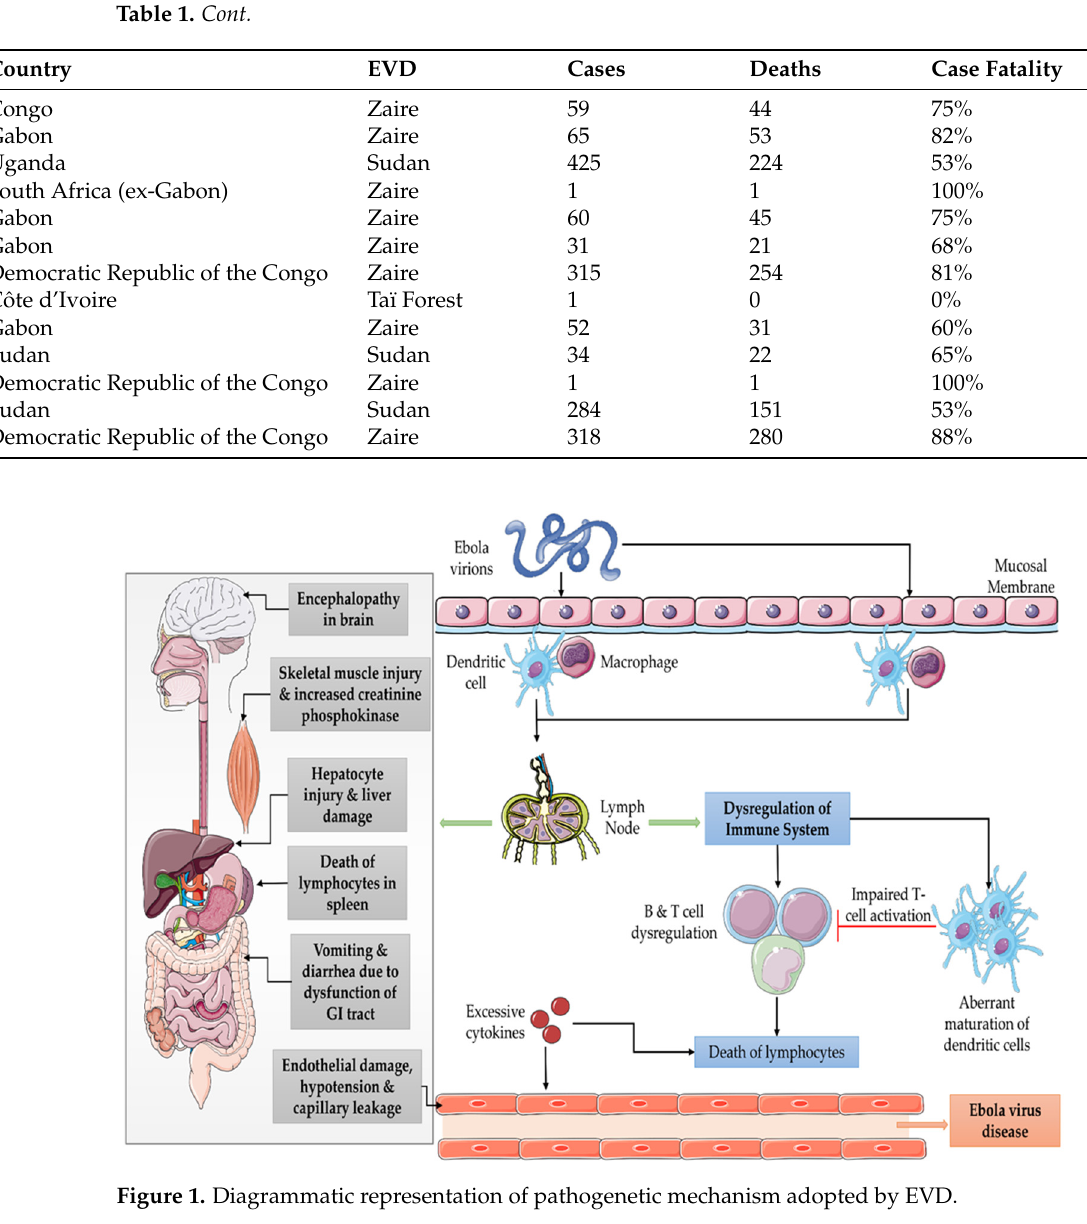
Figure 1. Diagrammatic representation of pathogenetic mechanism adopted by